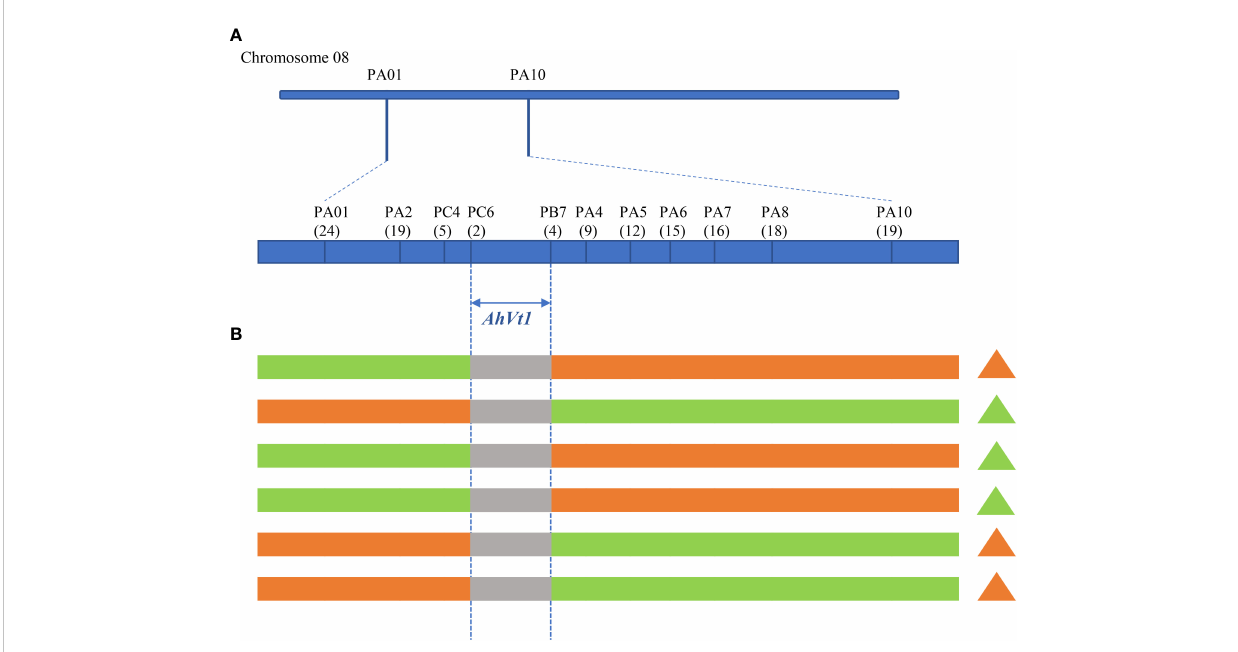
FIGURE 5 Narrow down the mapping region of AhVt1. (A) . Genetic mapping of AhVt1 on chromosome 08 based on individuals from the segregating population. The number of recombinants between adjacent markers is indicated under the linkage map. (B) . The genotype of important recombinants that determine the mapping region of AhVt1 . The green bar represents the genomic segment from FH8, the orange bar represents the genomic segment from Wc, the grey bar represents the genomic segment where the recombination occurs. The triangle represents the testa phenotype of corresponding recombinant. The green triangle represents the pure-color testa, while the orange triangle represents the variegated testa